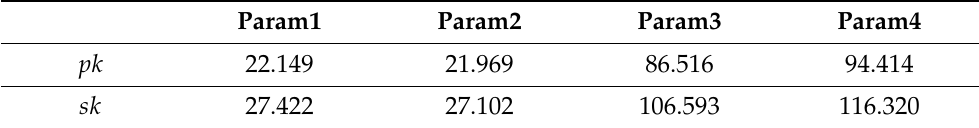
Table 7. A single key size for fully homomorphic encryption (FHE) (in